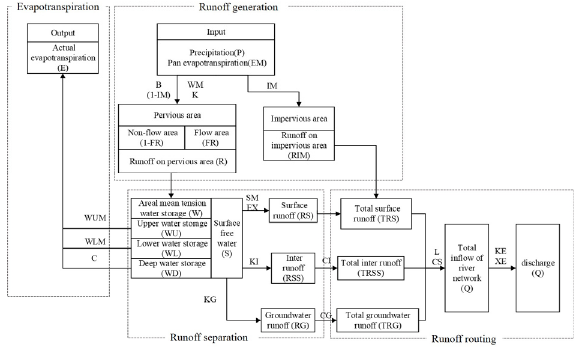
Figure A2. Structure of Xinanjiang model (adapted from [46]).